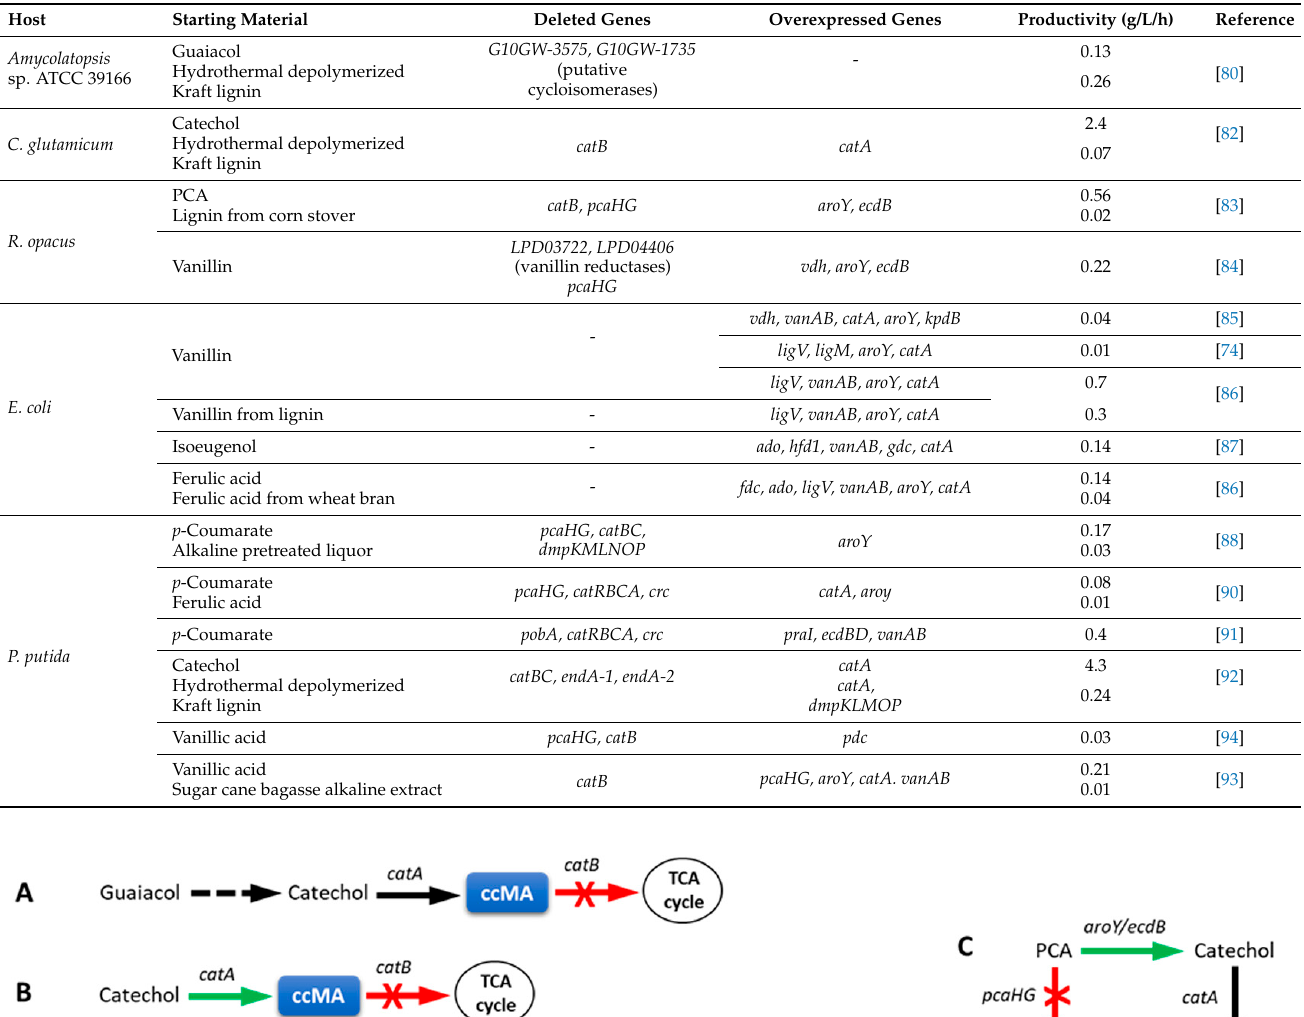
Table 3. Metabolic engineering strategies for constructing optimized ccMA-producing strains.